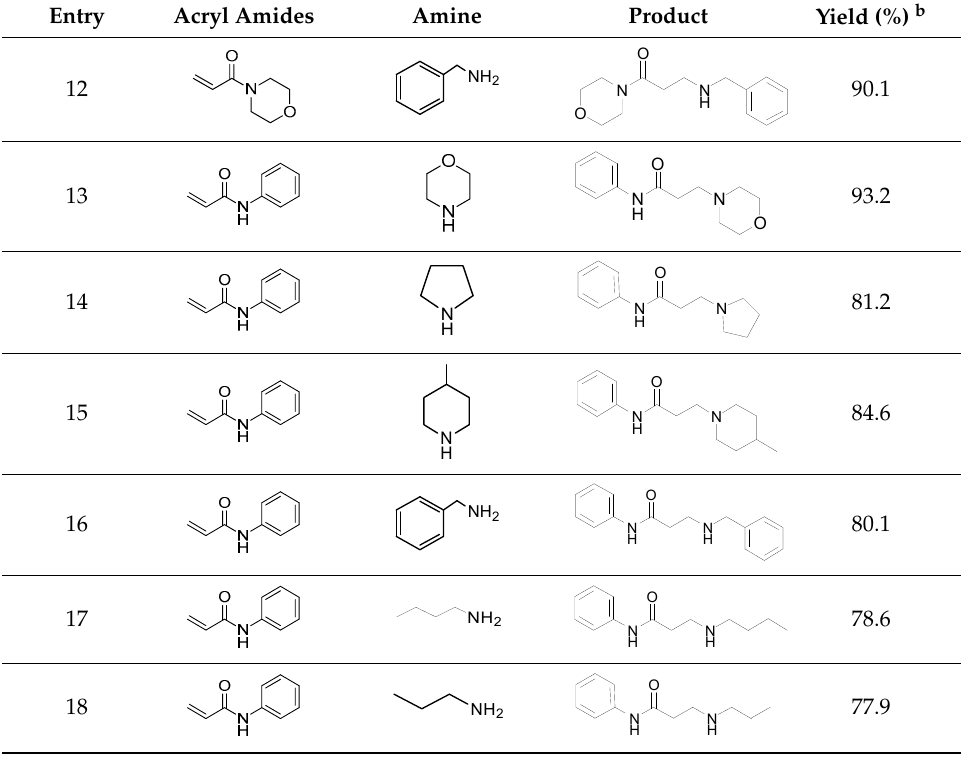
Table 1. Influence of the Fe 3 O 4 nanoparticles on the aza ‐ Michael addition of various substituent on N position of acryl amides with morpholine. a